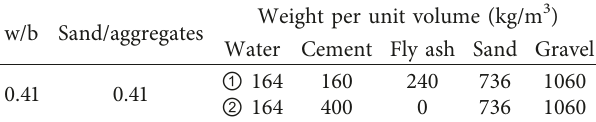
Table 1: Concrete-mixed